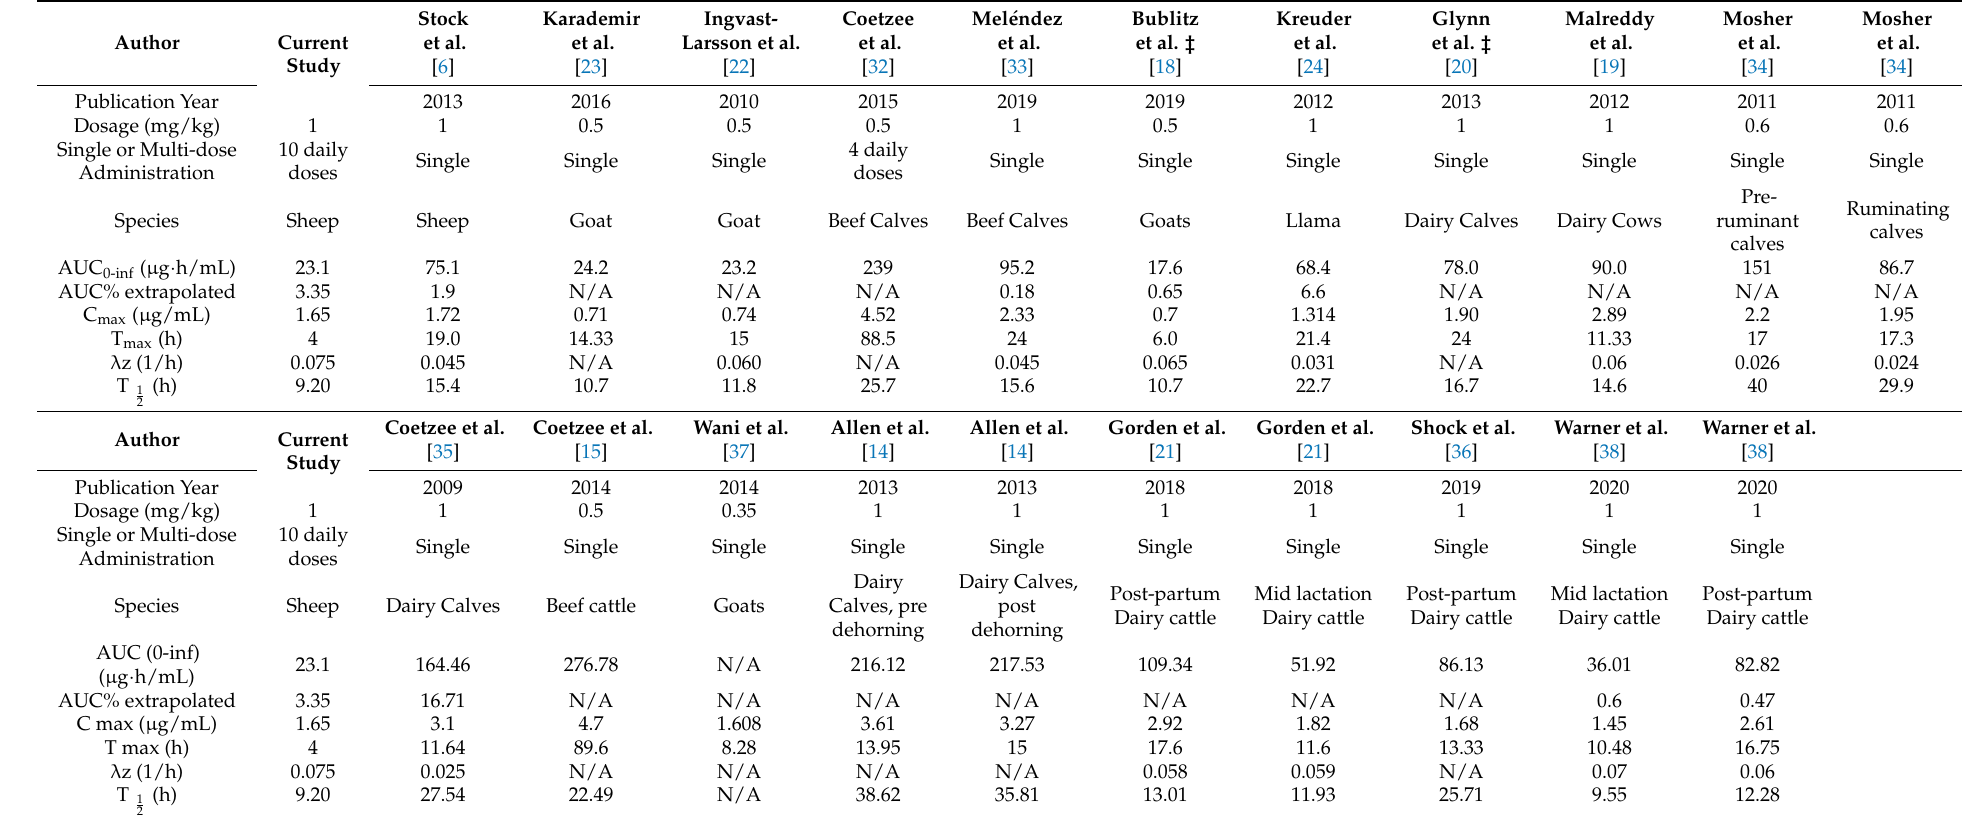
Table 4. Summary of published (as of December 2020) plasma PK parameters for meloxicam in ruminants and pseudo ruminants following oral administration of meloxicam. Data are reported as means except where